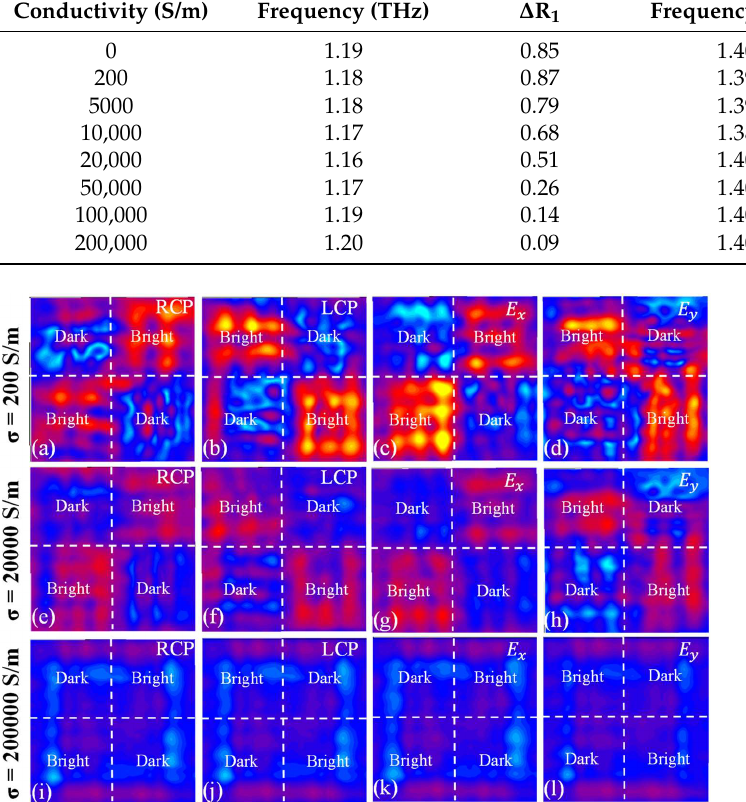
Figure 6. ( a – d ) are the actual effect diagrams of near-field imaging for linearly polarized waves and circularly polarized waves when the conductivity of vanadium dioxide is 200 S/m. ( e – h ) are the actual effect diagrams of near-field imaging for linearly polarized waves and circularly polarized waves when the conductivity of vanadium dioxide is 20,000 S/m. ( i – l ) are the actual effect diagrams of near-field imaging for linearly polarized waves and circularly polarized waves when the conduc- tivity of vanadium dioxide is 200,000